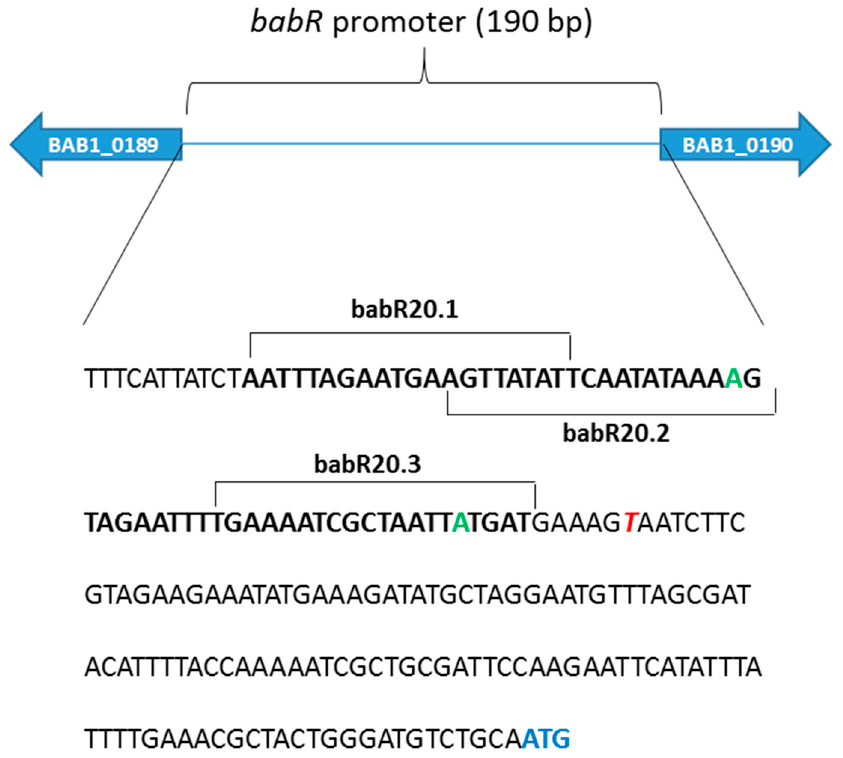
Figure 1. Schematic representation of babR promoter characterized by Caswell C.C. et al. [22]. Green indicates the position at -35 and -10 from the transcription starting site which is indicated in italic red. The ATG of the babR gene is reported in blue. The sequence of babR60 used in the electrophoretic mobility shift assays (EMSAs) of MucR is in bold. The sequences of the three 20 bp oligonucleotides tested as MucR target sites are also indicated (babR20.1, babR20.2 and babR20.3). The double-stranded oligonucleotide babR60 was used as a target site of MucR in EMSA. The results show that MucR is able to bind babR60 (Figure 2a) demonstrating that the babR promoter is a target of MucR in B. abortus .